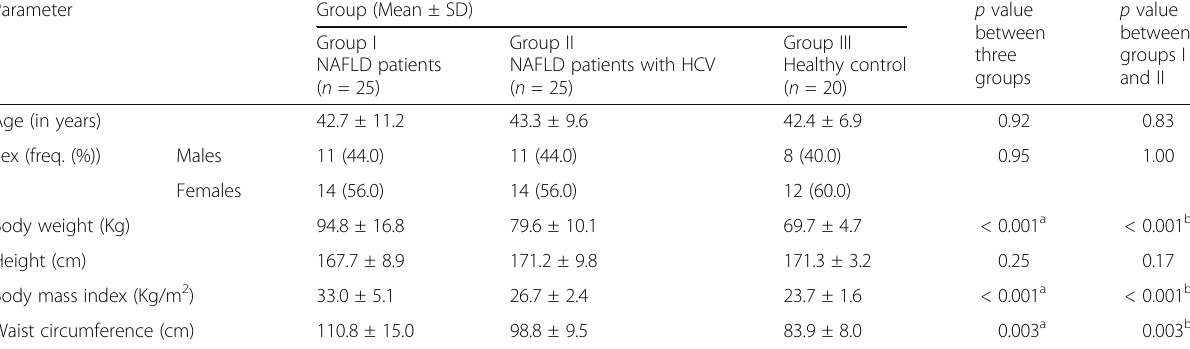
Table 2 Comparative analysis between the studied groups as regard age, sex, and anthropometric measurements Parameter